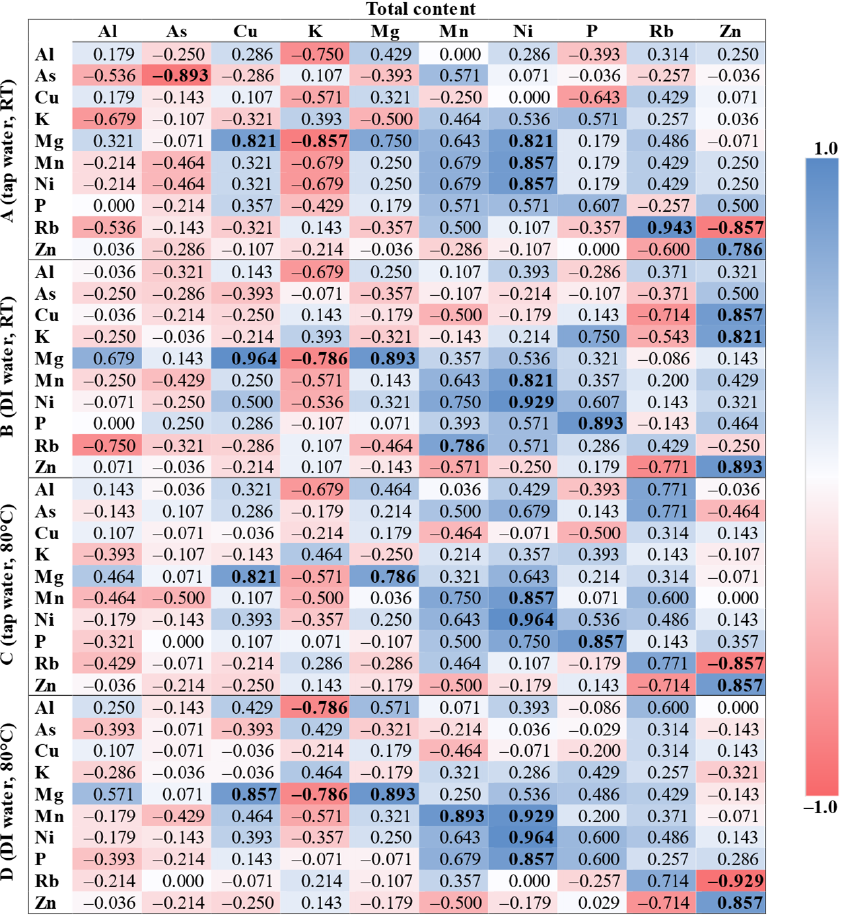
Figure 1. The Spearman’s correlation matrix of 10 elements for total and extractable content. Statistically significant coefficients ( p < 0.05) are bolded.